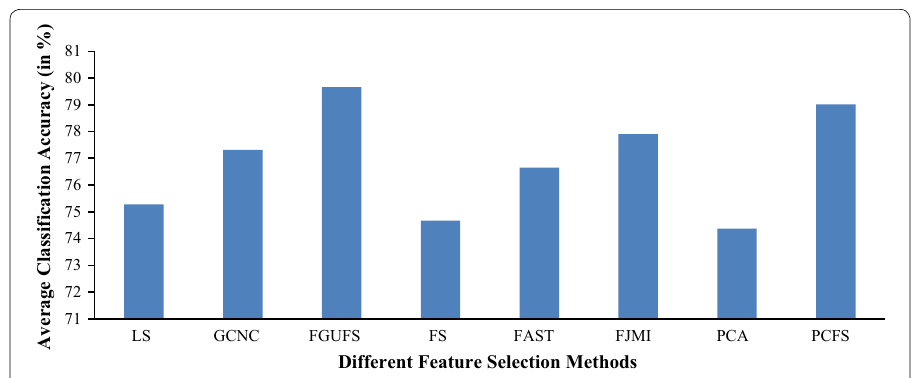
Table 3 Number of times different methods achieve the best results with SVM classifier Dataset